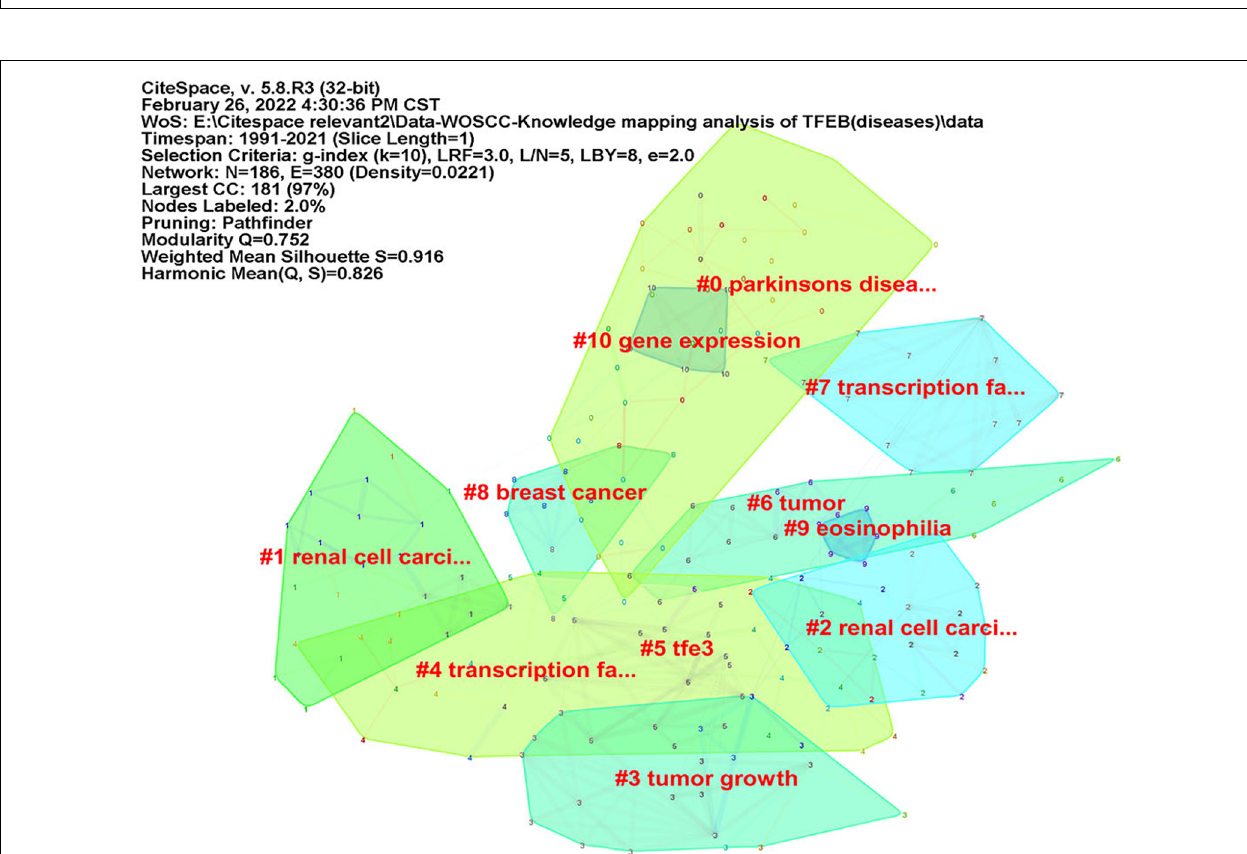
FIGURE 4 | The timeline view of co-cited references from publications in TFEB research.